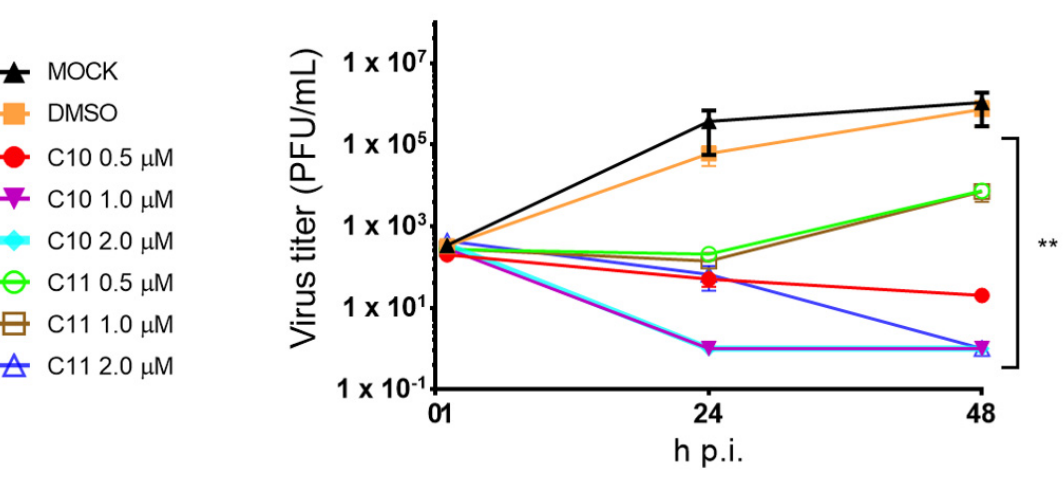
Figure 6. Effects of C10 and C11 on influenza A virus (A/Panama/2007/1999 (H3N2)) replication using an ex vivo human tumor-free lung model. Tissues were infected with 1 × 10 5 plaque-forming units (PFU)/mL of this recombinant virus for 1 h and further treated with both compounds (0.5, 1.0, and 2.0 µM) for 48 h. Tissue supernatants were collected at 1, 24, and 48 h post-infection (p.i.) and titrated on MDCK cells. Each time point represents mean (±SD) of four independent experiments. ** p < 0.01 vs. MOCK, two-way ANOVA, post hoc test Dunnet.